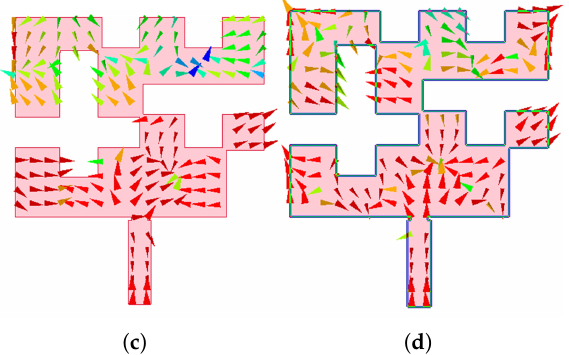
Figure 10. Surface current distribution of genetically optimized antenna ( a ) at 28.3 GHz, ( b ) at 38.1 GHz, ( c ) at 46.6 GHz, and ( d ) at 60.0 GHz.